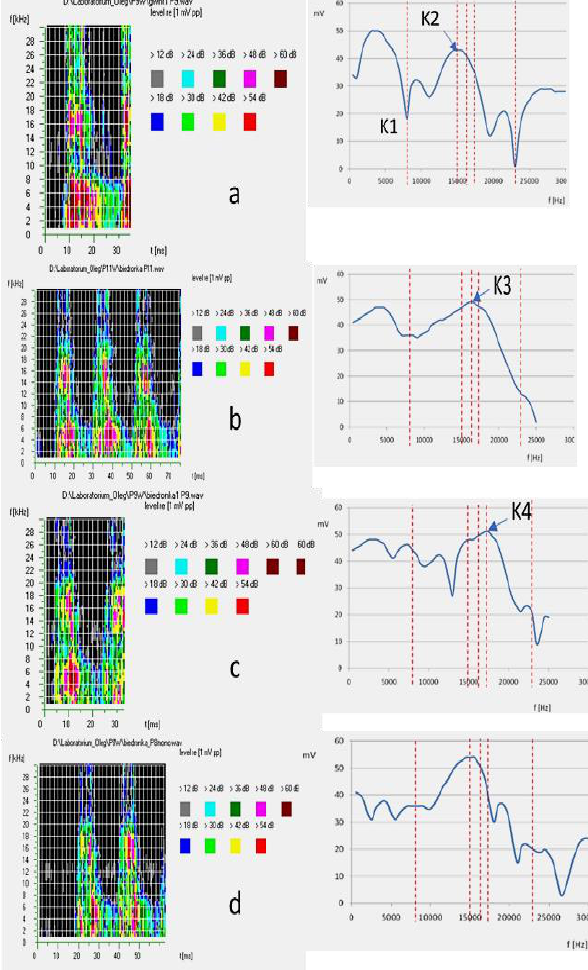
Fig. 8. Time-frequency spectrograms and energy of the EA signal in the recorded frequency band at a specific moment in time for the reference fuel: a, b, c and d – fuel injection start pressure, respectively 20.0; 22.0; 24.0 and 26.0 MPa; K1, K2, K3, K4 – reference